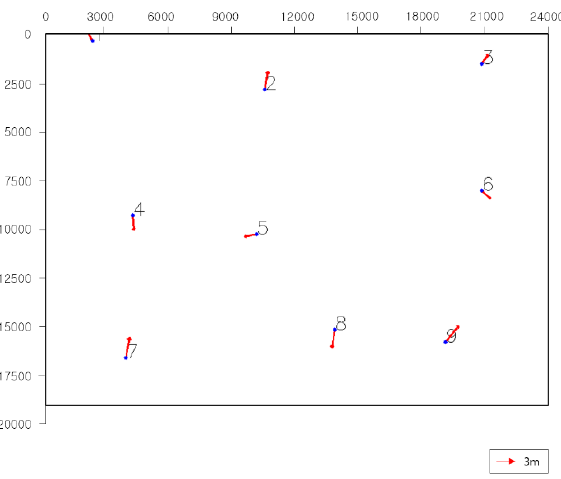
Figure 8. Geometric errors in precise orthoimage of Pyeongyang compared with aerial orthoimage. Figure 9 and 10 show the geolocation errors of the Seoul and Pyeongyang orthoimages. It is possible to check relatively lower accuracy of Pyeongyang image. Figure 11 shows enlarged overlap between the Chungcheongnamdo orthoimage and digital map. It show correctness of boundaries between orthoimage and digital map.